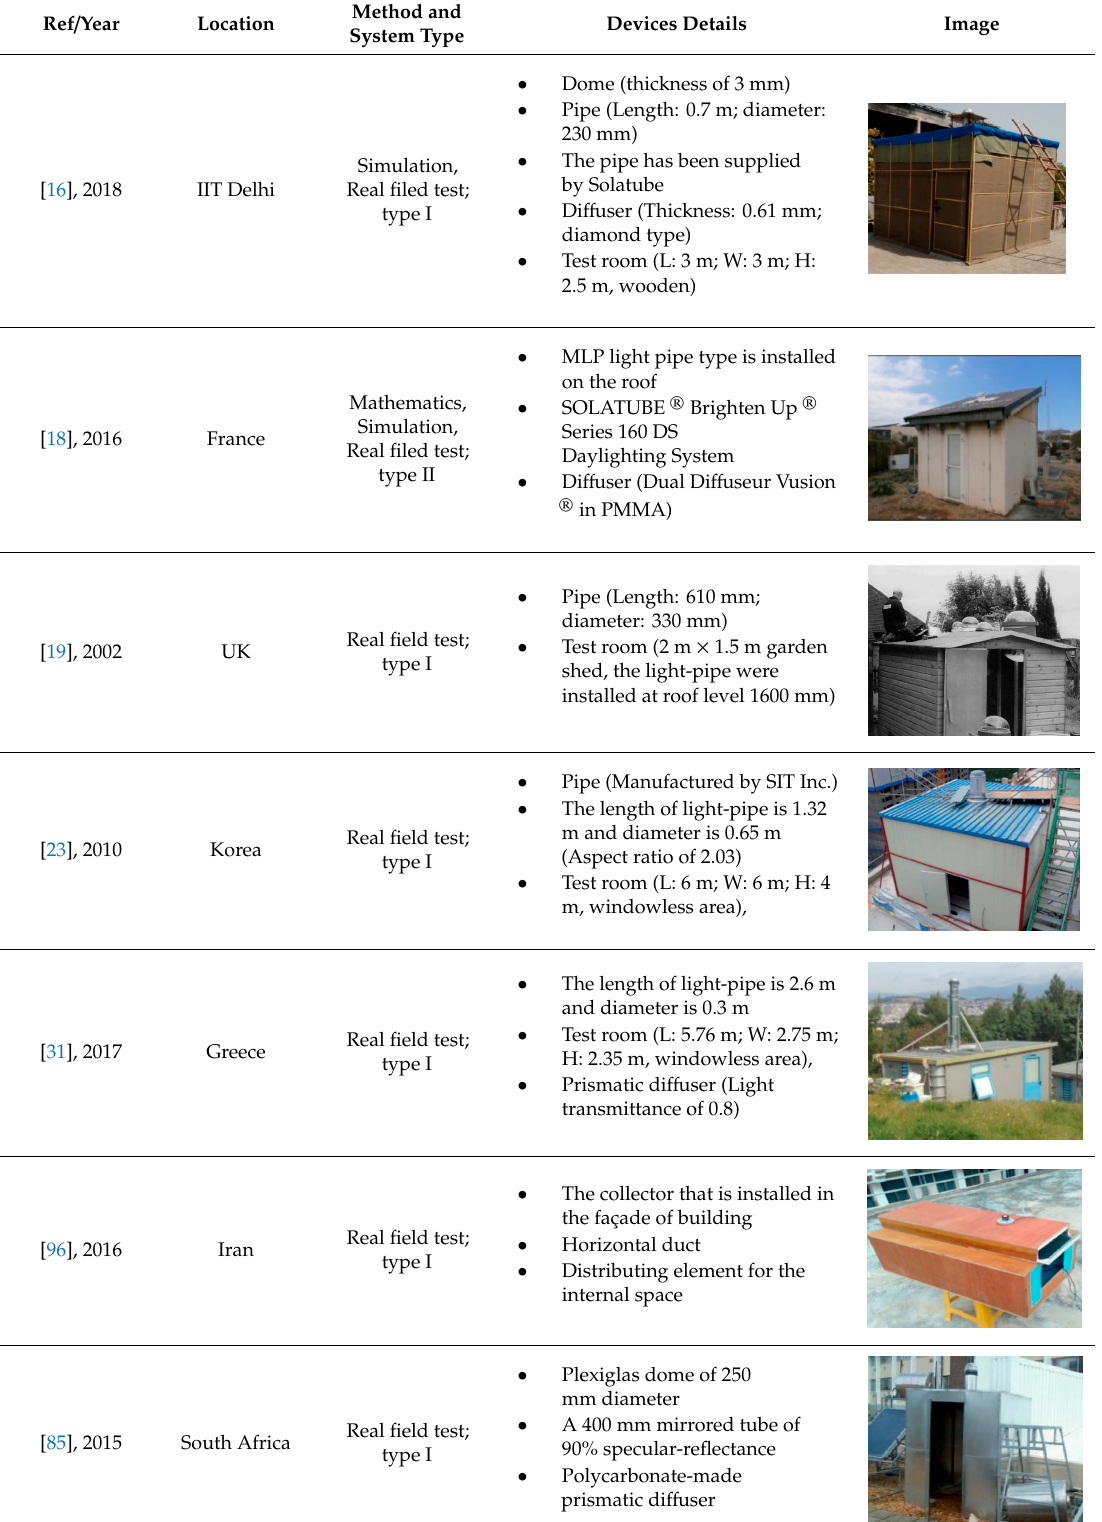
Table 4. Experimental field of prototype tubular daylight guidance systems.